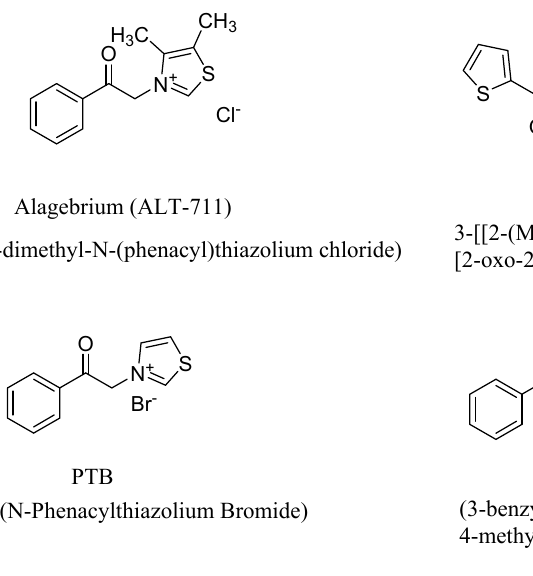
Figure 11. Structures of the AGE breaker compounds.